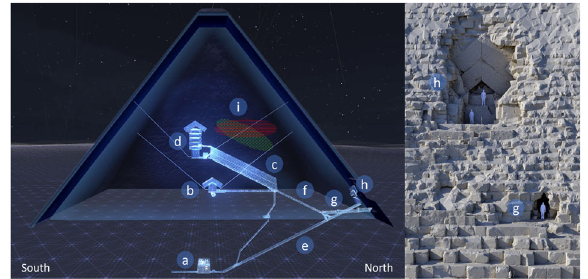
Fig.1|East-WestcutviewoftheGreatPyramidandfrontviewoftheNorthface Chevron area. a Subterranean chamber, b queen ’ s chamber, c grand gallery, d king ’ s chamber, e descending corridor, f ascending corridor, g al-Ma ’ mun corri- dor, h northfaceChevronarea, i ScanPyramidsBigVoidwithhorizontalhypothesis (red hatching)andinclined hypothesis (green hatching)as published inNovember 2017 6 .Alltheseimageswereobtainedfroma3Dmodelizationusingdedicatedlaser surveys and photogrammetry data.